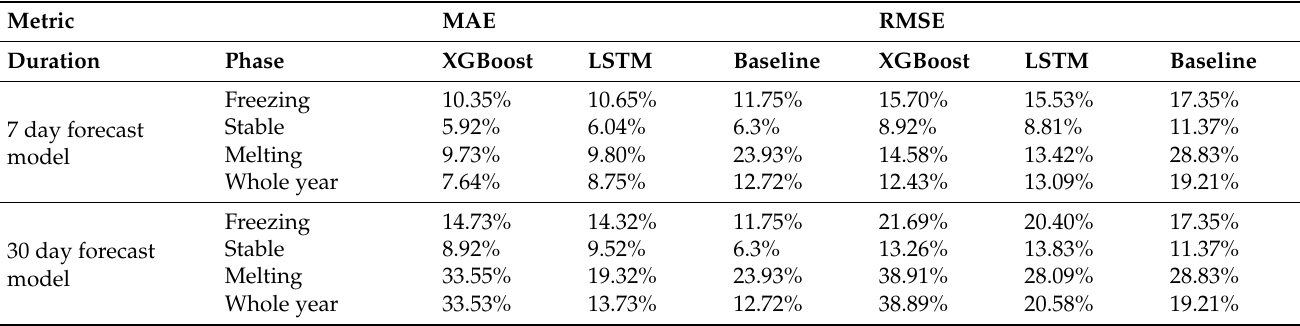
Table 3. Prediction error (RMSE and MAE) on the test set before shuffling.